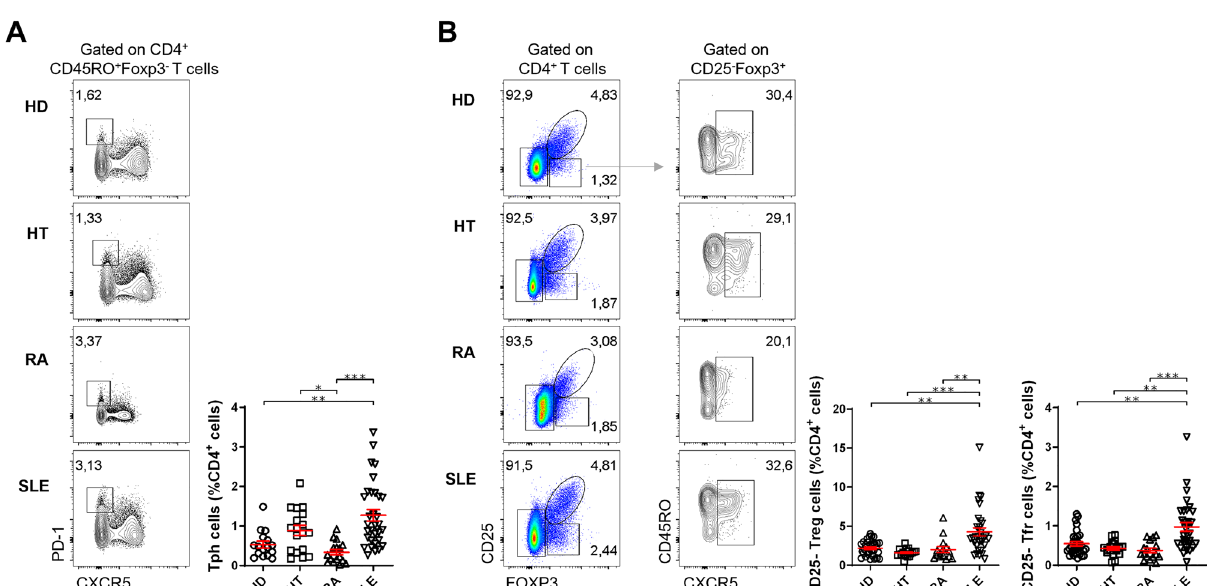
Figure 3. SLE patients show an increased frequency of circulating Tph and CXCR5 + CD25 – Foxp3 + T follicular cells. Representative plots (left) and pooled data (right) of the frequency of (A) Tph cells and (B) CXCR5 + CD25 – Foxp3 + T cells in the peripheral blood of HT (n = 18), RA (n = 16), and SLE (n = 32) patients, and sex- and age- matched HD (A: n = 16; B: n = 31). Each data point represents an individual subject; bars represent mean ± SEM; * p < 0.05, ** p < 0.01, *** p < 0.001, Kruskal–Wallis one-way analysis of variance (ANOVA) test with Dunn’s comparison